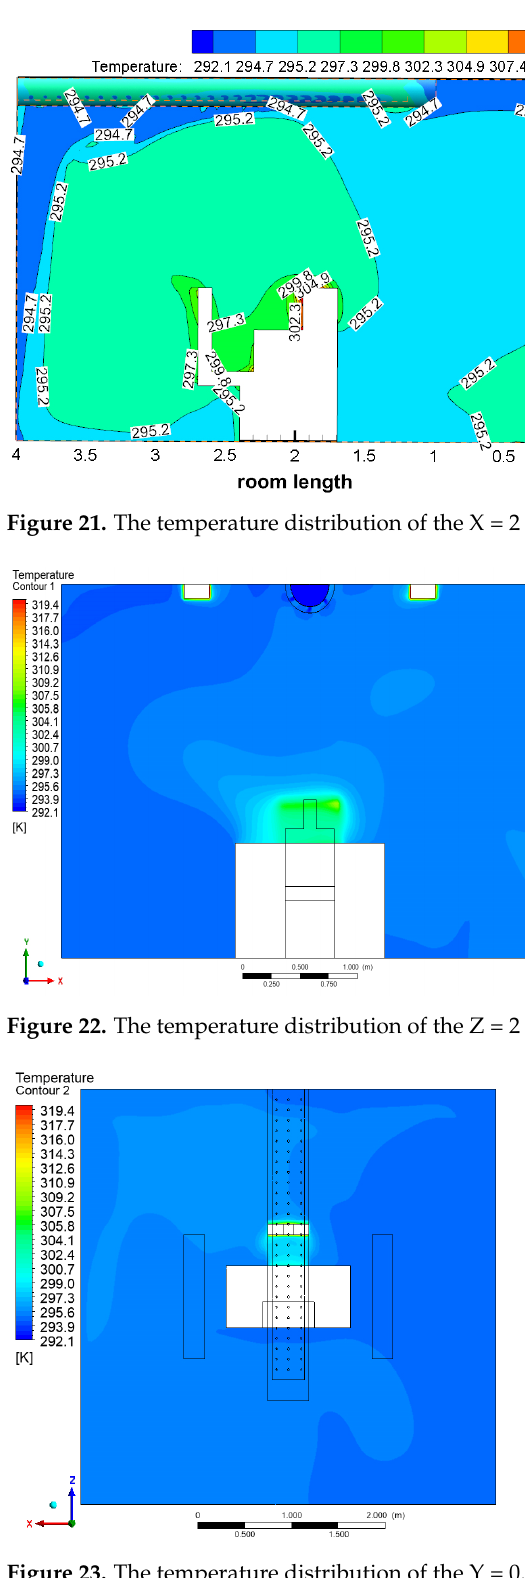
Figure 24. The temperature distribution of the X = 2 m section. Figure 25. The temperature distribution of the Z = 2 m section.